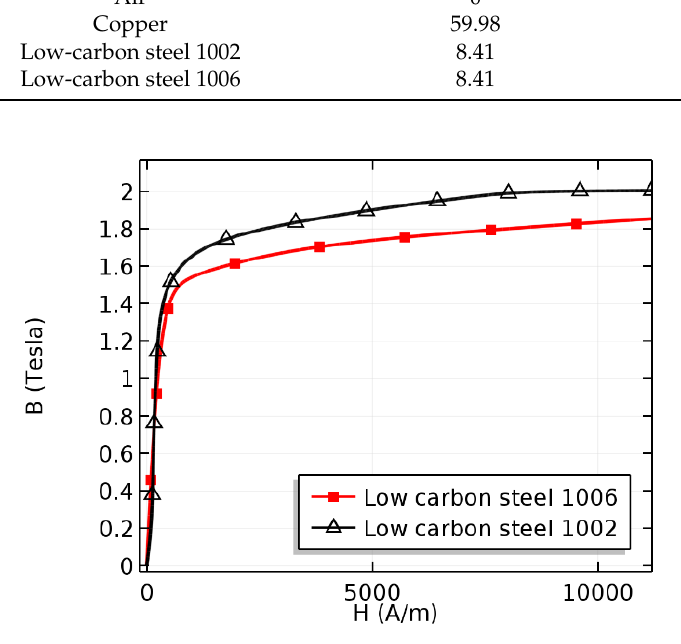
Figure 4. BH curve of low-carbon steel 1002 and 1006.